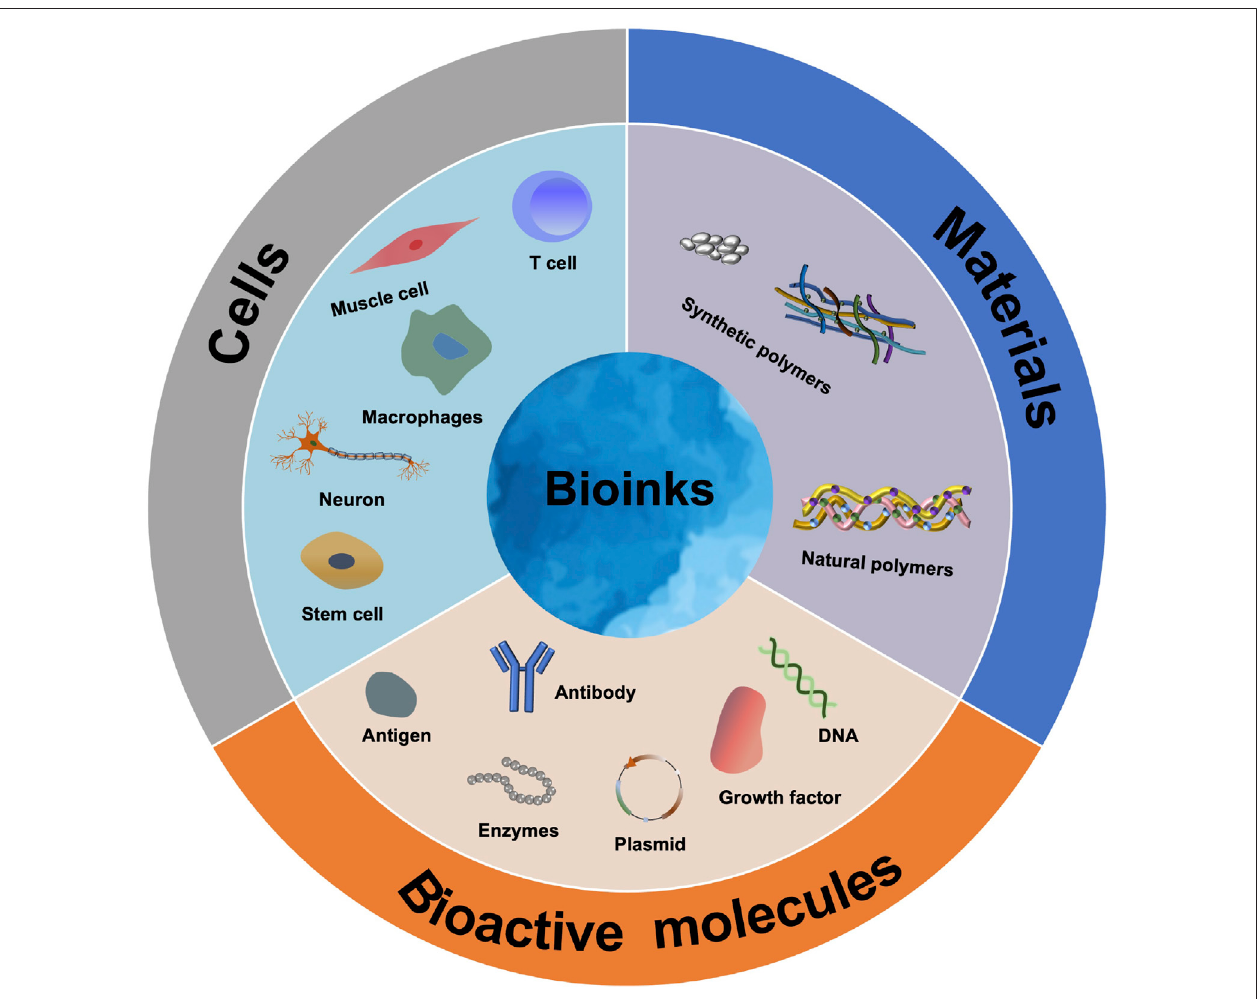
FIGURE 2 | Three types of bioinks for 3D